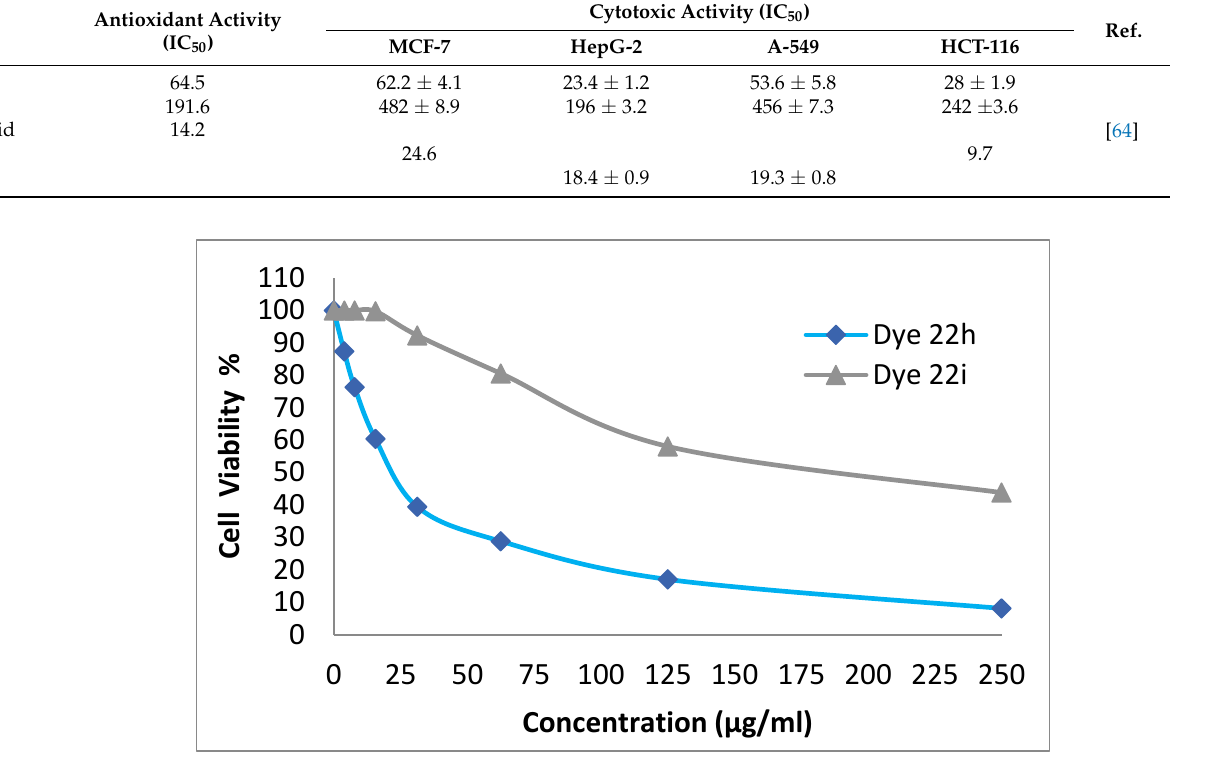
Figure 6. Antitumor (HepG-2) activities of disperse dyes 22h and 22i.